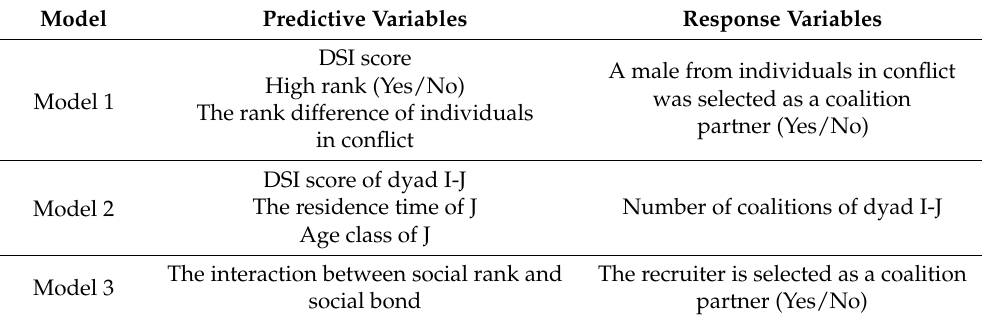
Table 3. Structure of models 1–3, study on male Tibetan